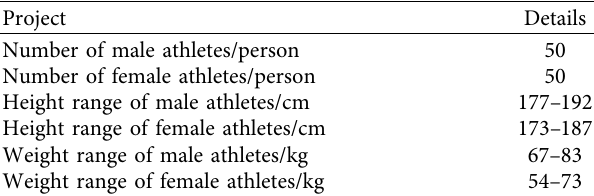
Figure 1: Original shooting image of athletes.